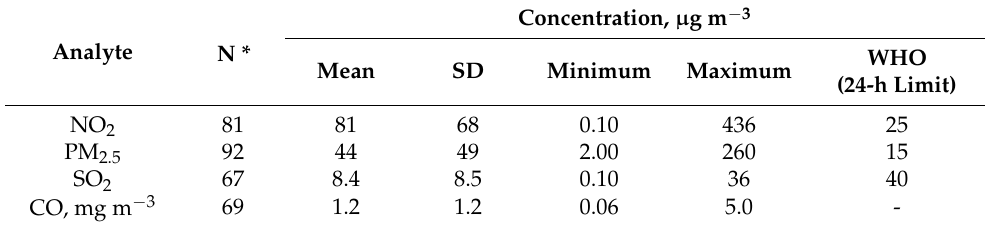
Table 4. Descriptive statistics of the concentrations of NO 2 , SO 2 , CO, and PM 2.5 .